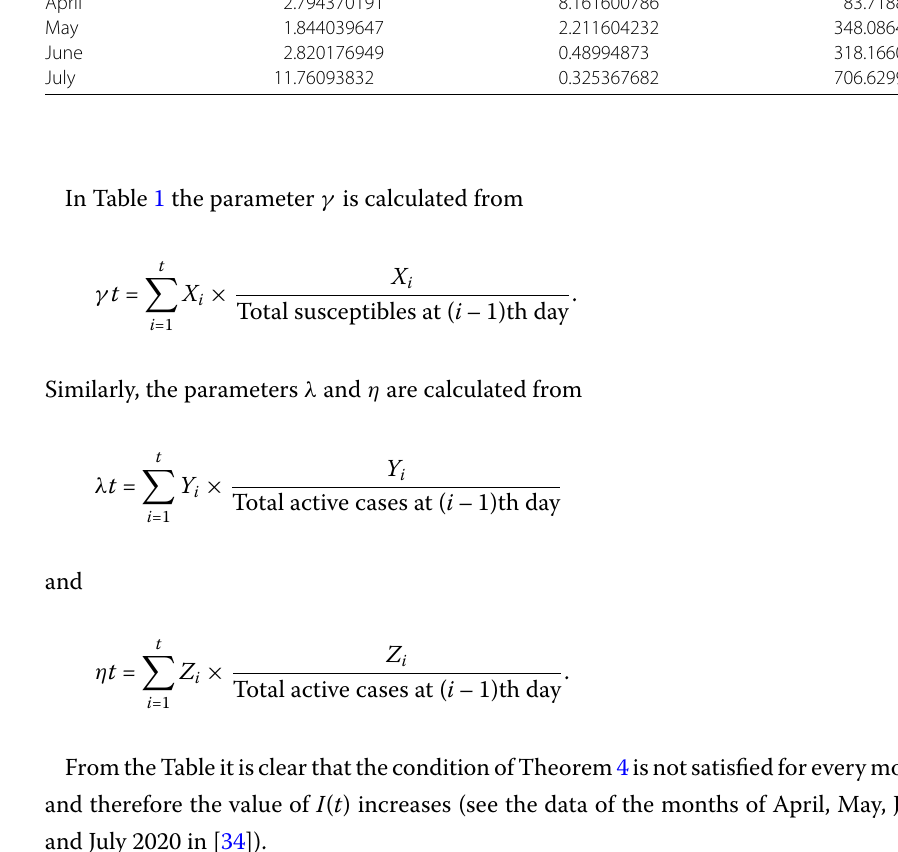
Table 1 Values of the stochastic parameters calculated from data of USA during COVID-19 for four months Month γ λ η